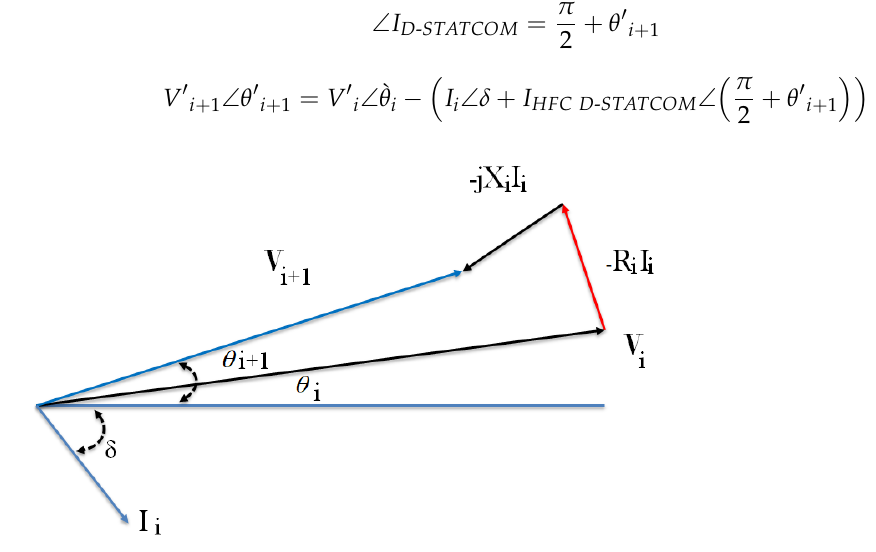
Figure 13. The current and voltage phasor technique diagram [75].